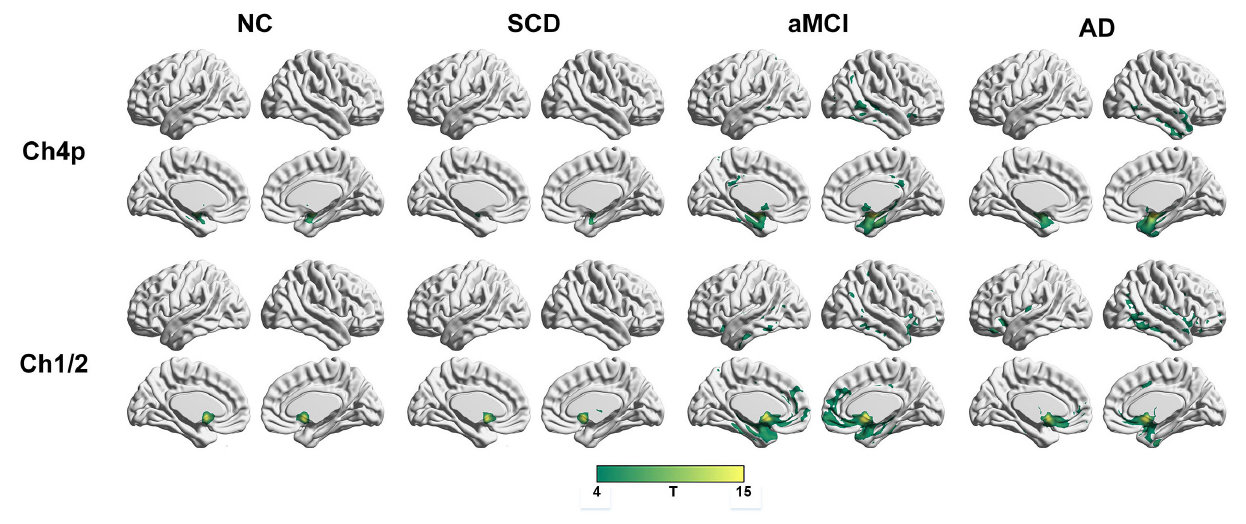
FIGURE 3 | Structural covariance networks seeding from the Ch4p and Ch1/2 within groups. T-statistic maps, p < 0.05, corrected by false discovery rate (FDR) with cluster size larger than voxels. L, left; R, right; AD, Alzheimer’s disease; NC, normal control; aMCI, amnestic mild cognitive impairment; SCD, subjective cognitive